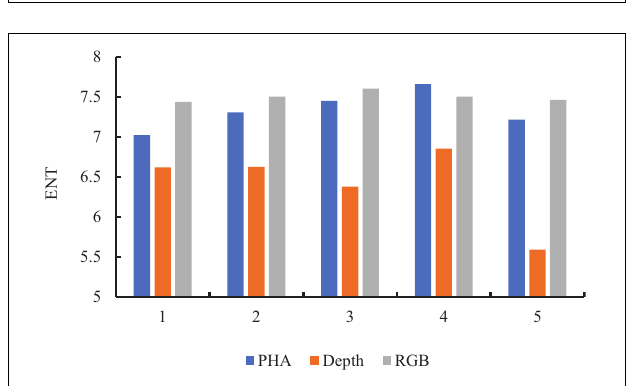
FIGURE 5 | Entropy values of PHA, RGB, and depth